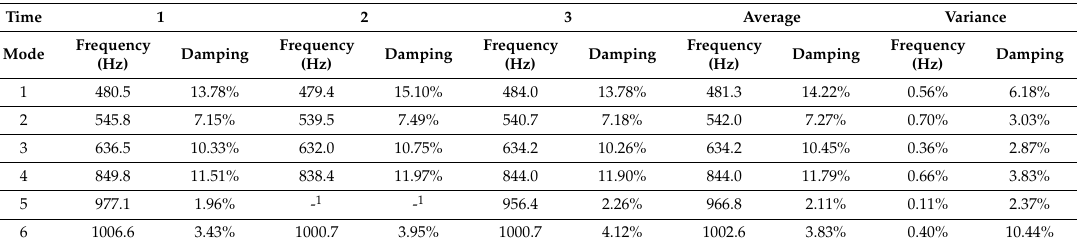
Table 3. Experimental Results.